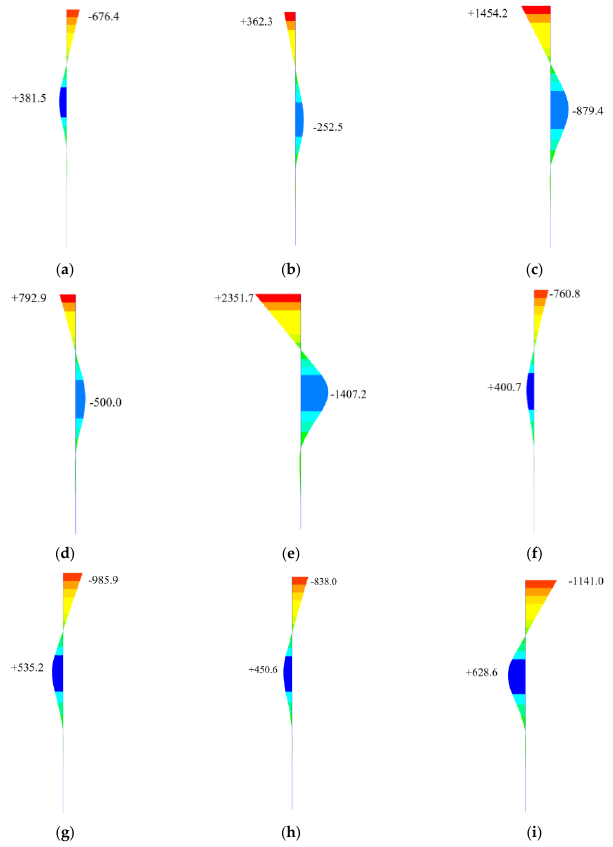
Figure 6. Pile bending moment under each scheme (Unit: kN · m): ( a ) initial state; ( b ) pile-bending moment of scheme 1; ( c ) pile-bending moment of scheme 2; ( d ) pile-bending moment of scheme 3; ( e ) pile-bending moment of scheme 4; ( f ) pile-bending moment of scheme 5; ( g ) pile-bending moment of scheme 6; ( h ) pile-bending moment of scheme 7; ( i ) pile-bending moment of scheme 8.